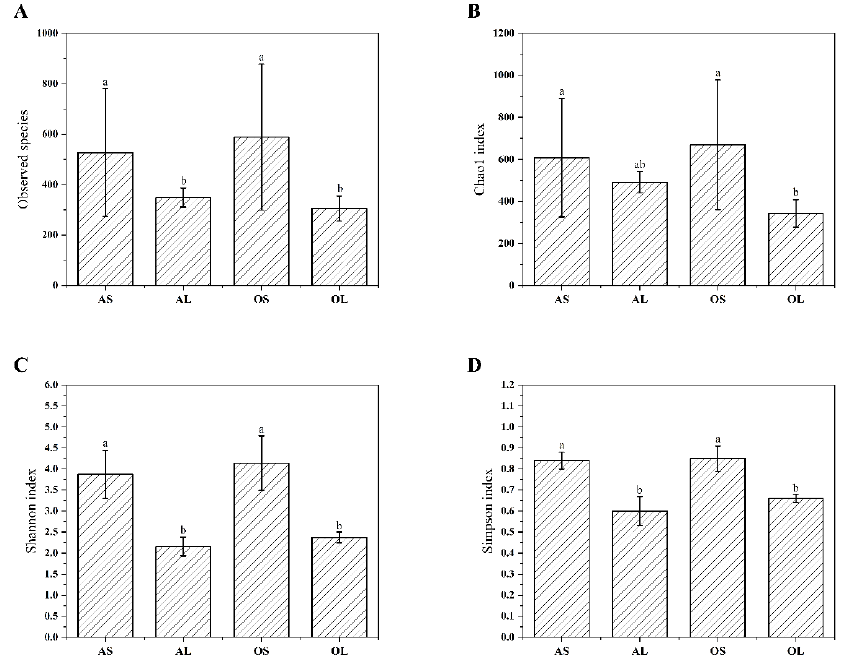
Figure 1. Effects of bamboo part consumption and age on alpha diversity indices of fecal microbiome in captive giant pandas. ( A ) Observed species. ( B ) Chao1 index. ( C ) Shannon index. ( D ) Simpson index. AS ( n = 11), adult giant pandas fed with bamboo shoots; AL ( n = 11), adult giant pandas fed with bamboo leaves; OS ( n = 11), old giant pandas fed with bamboo shoots; OL ( n = 11), old giant pandas fed with bamboo leaves. In each panel, values are presented as mean ± standard error; bars with different letters denote a significant difference ( p < 0.05)